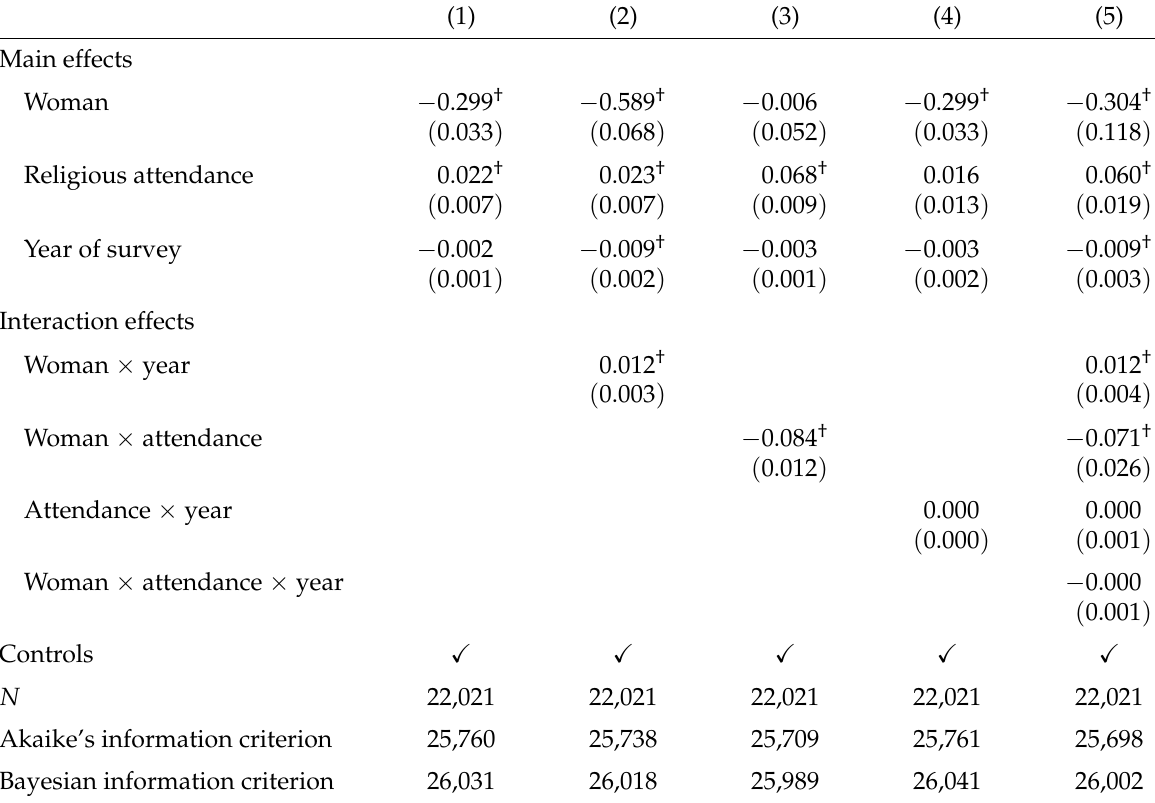
Table 1: Logistic regression on desire to work when not financially necessary by gender and religious service